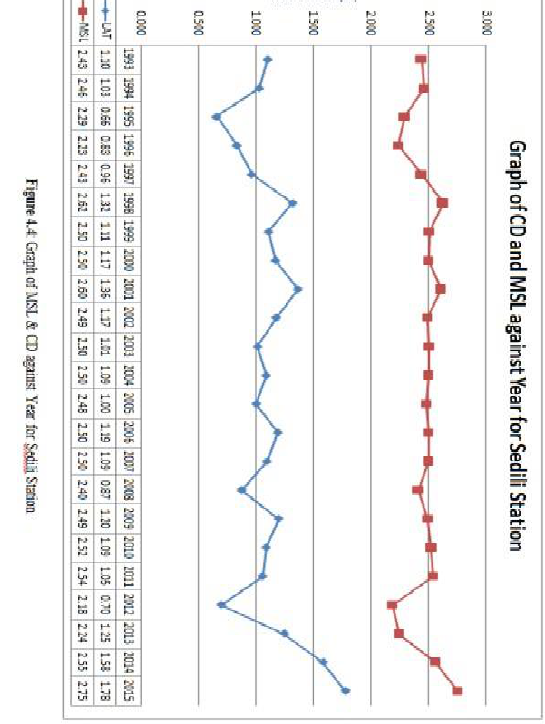
Figure 8. Cendering Tide Station